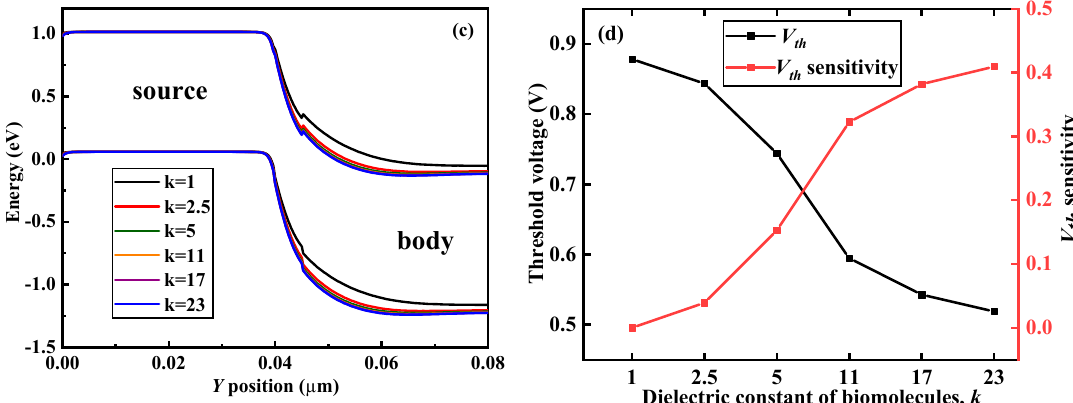
Figure 2. ( a ) Transfer characteristics, ( b ) I on and S cur , ( c ) energy band variation with respect to the y -axis, and ( d ) S Vth of the DM-LTFET biosensor for different values of k at V d = 0.5 V, V g = 1 V, and T c = 5 nm.